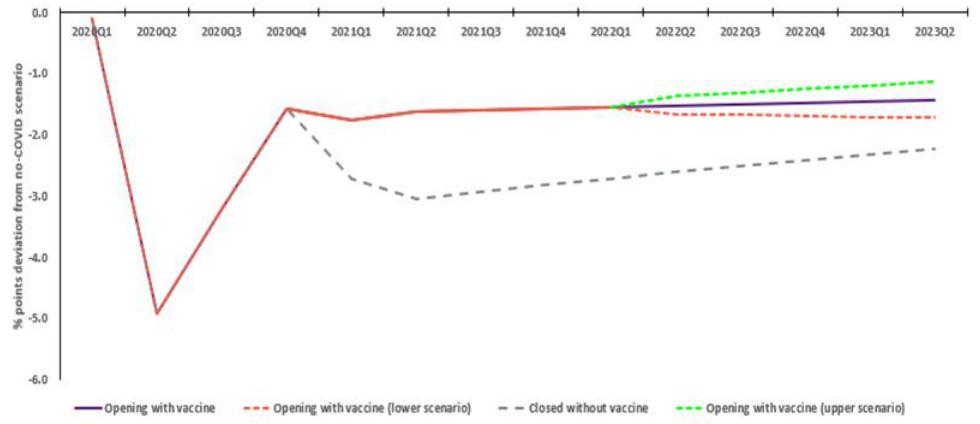
Figure 5. Employment: Estimated deviation national headcount employment relative to no COVID scenario (000s). Note: Modelling includes actual Australian employment statistics up until quarter four 2021.